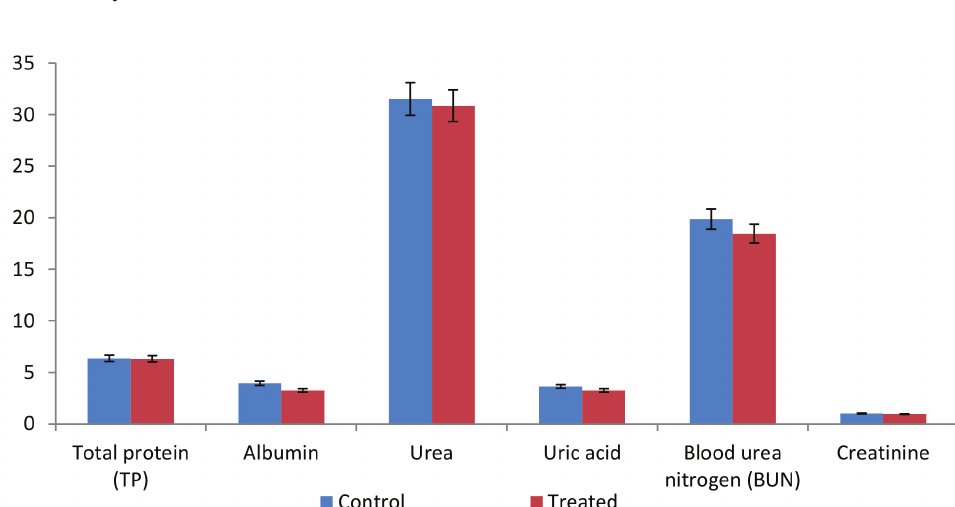
FIGURE 2 - Diuretic activity of BRBD in rats.